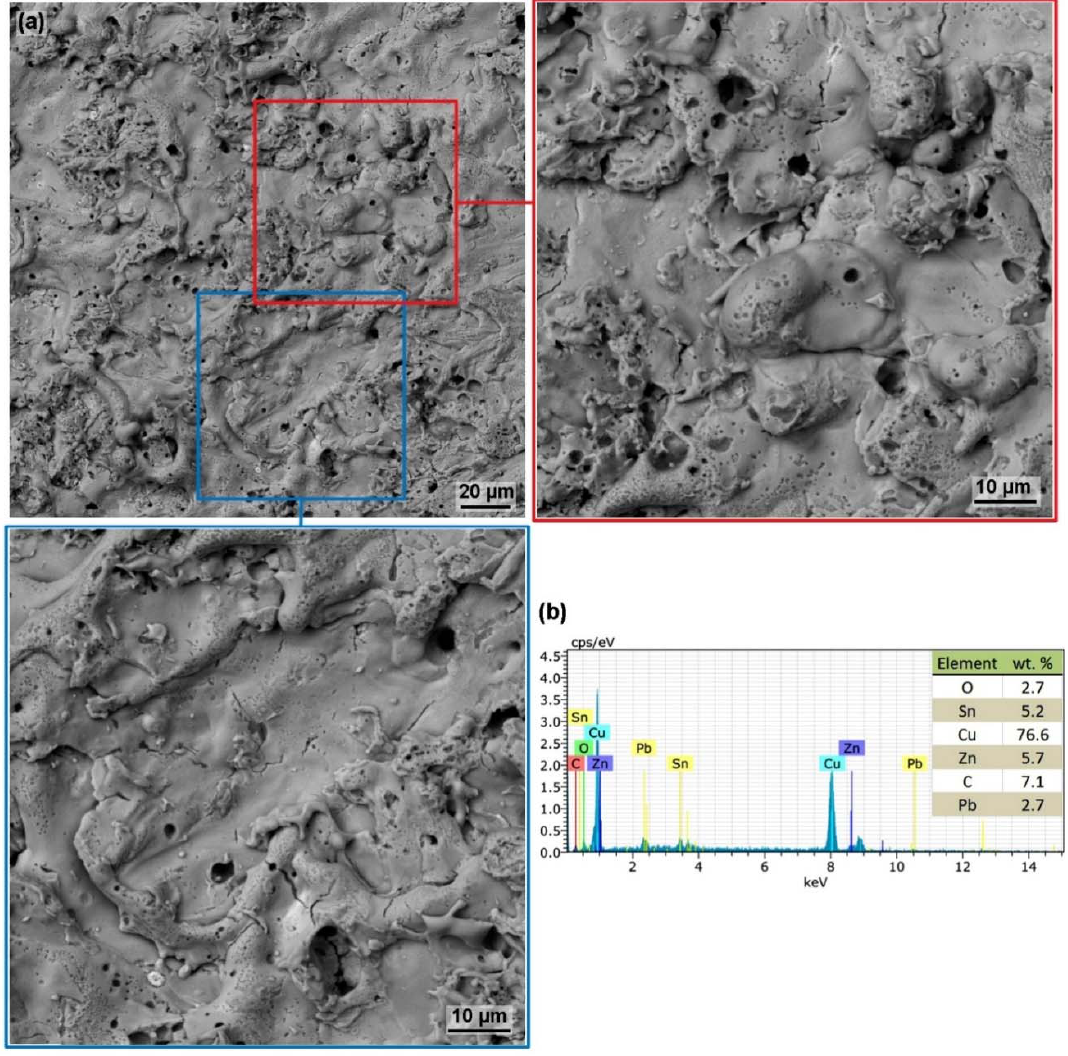
Figure 6. The surface morphology of Sample 20 with the lowest surface topography values machined with the parameters: U =70 V, T on =6 μ s, T off =50 μ s, v =14 m ∙ min − 1 and I =25 A, SEM (BSE) including details of two points and the chemical composition analysis ( a ) sample surface, ( b ) chemical composition analysis from the entire area shown in image ( a ).